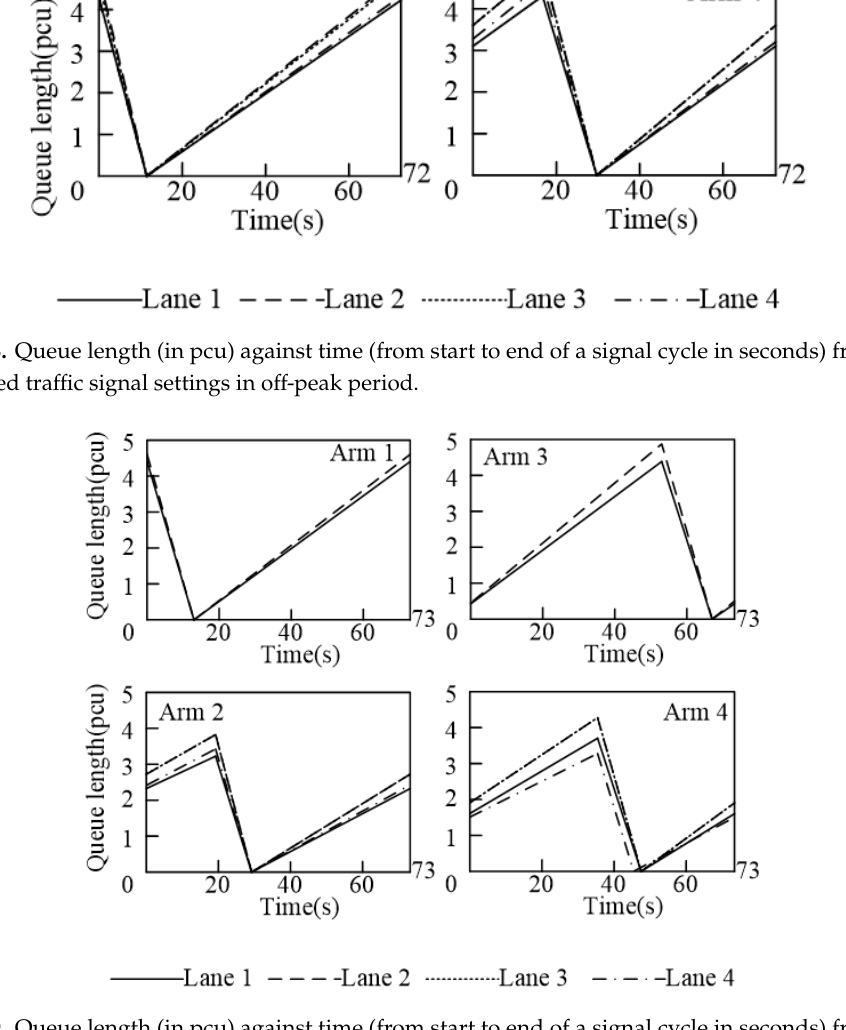
Figure 9. Queue length (in pcu) against time (from start to end of a signal cycle in seconds) from the optimized traffic signal settings in evening-peak period.